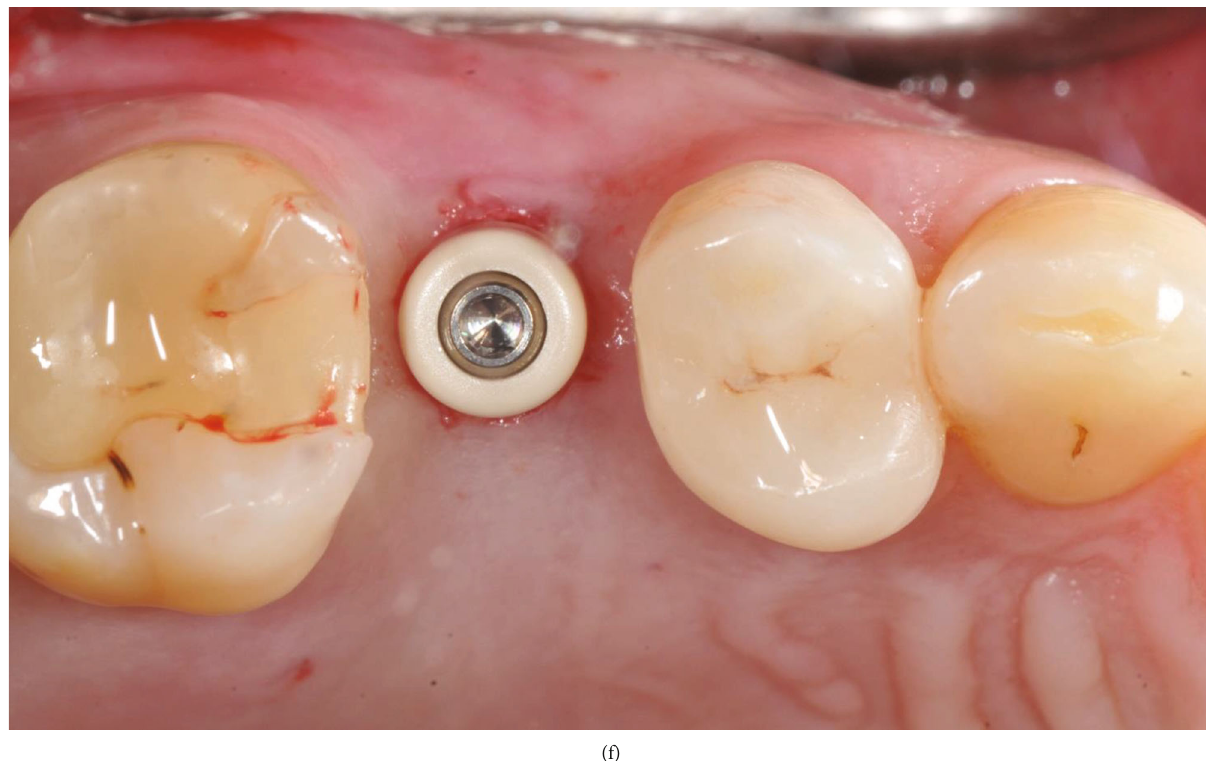
Figure 5: (a – c) Osteotomy by manual bone compactors (B&B Dental guided surgery kit, B&B Dental, San Benedetto, BO, Italy). (d) Filling of the implant site with inorganic bovine bone-derived mineral. (e) Dental implant positioning. (f) Positioning of the prosthetic